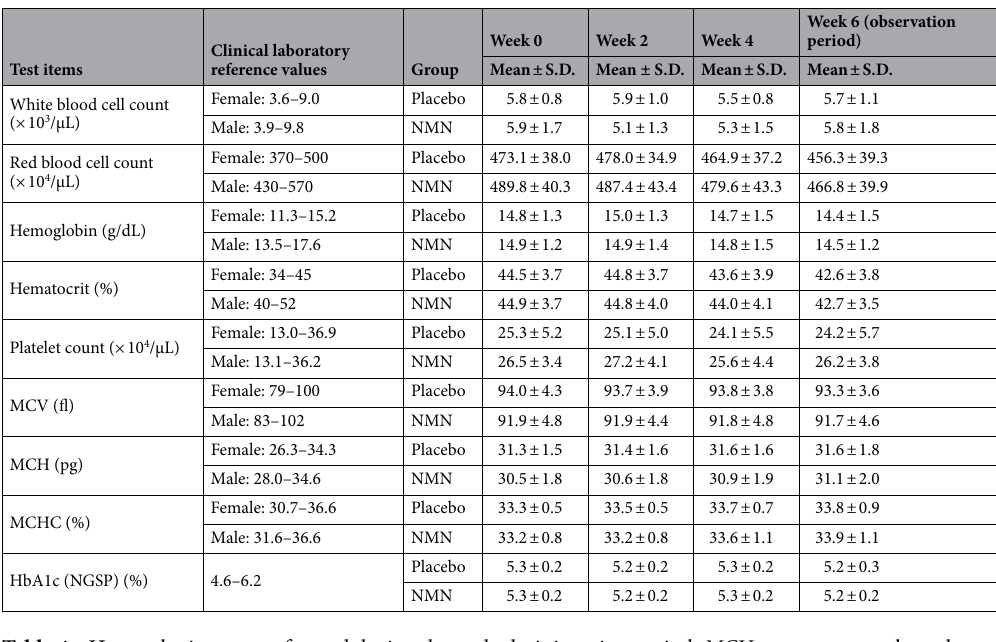
Table 4. Hematologic tests performed during the oral administration period. MCV mean corpuscular volume, MCH mean corpuscular hemoglobin concentration, MCHC mean corpuscular hemoglobin concentration, NGSP national glycohemoglobin standardization program. The number of participants in the placebo group was n = 15, while the NMN group comprised n = 16. Statistical significance was determined by two- way analysis of variance and Dunnett’s post hoc-test (two-tailed test) was used to compare the initial value measured at week 0 with all subsequent measurements. Between-group differences comparisons were made using a paired t-test or Welch’s t-test (only white blood cell